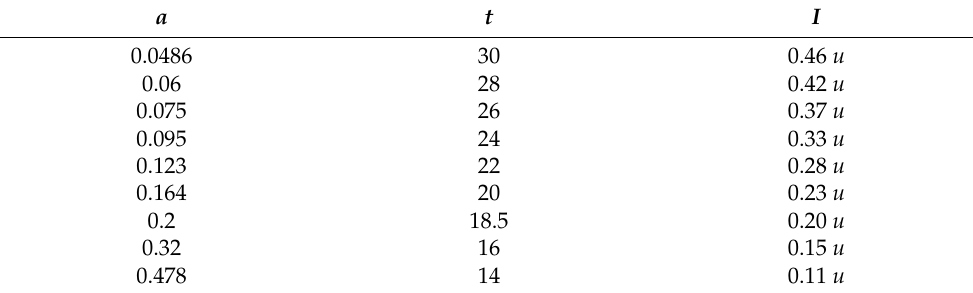
Table 1. Parameter values of the parabola and inflow